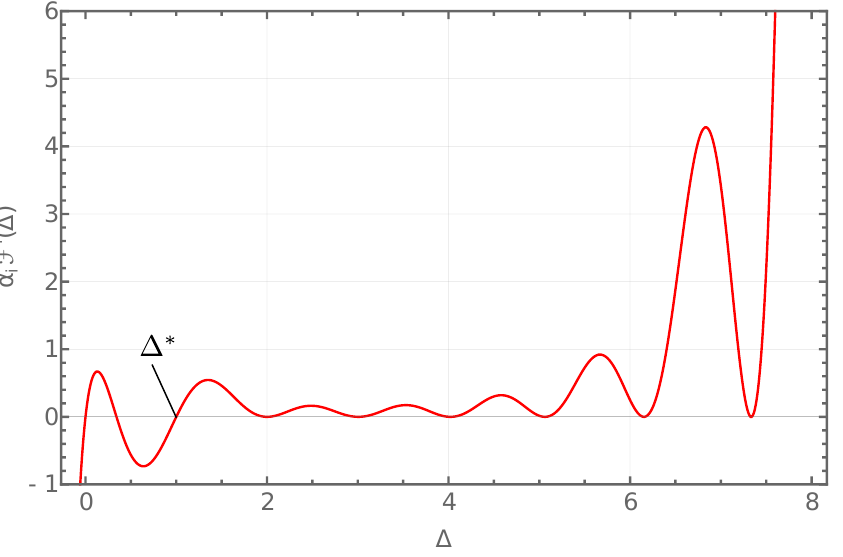
Figure 1 . Extremal functional for the spinless bootstrap at central charge c = 4 and number of functionals Λ = 10